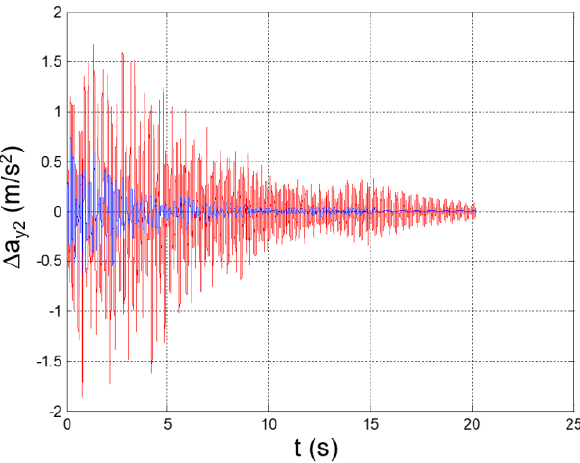
Figure 31. Seismic response, interstory acceleration at the 1st floor ( Δ 𝑎 y1 = 𝑎 y1 ).